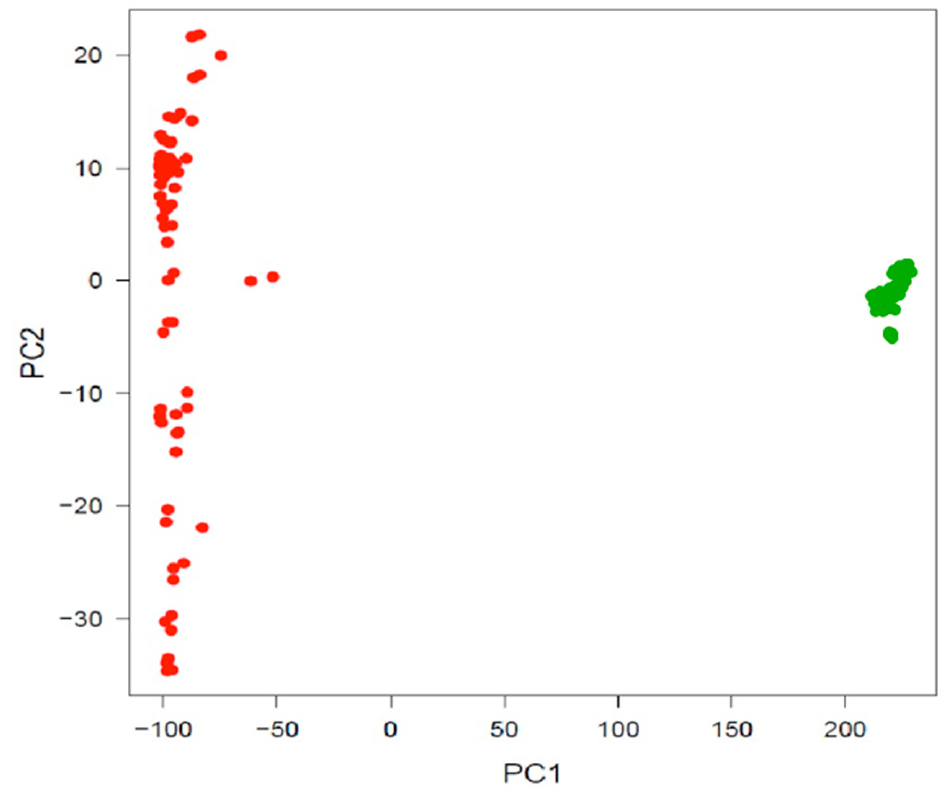
Figure 1. Principal component analysis (PCA) for the 110 common bean accessions from Brazil, using 28,823 SNPs markers.